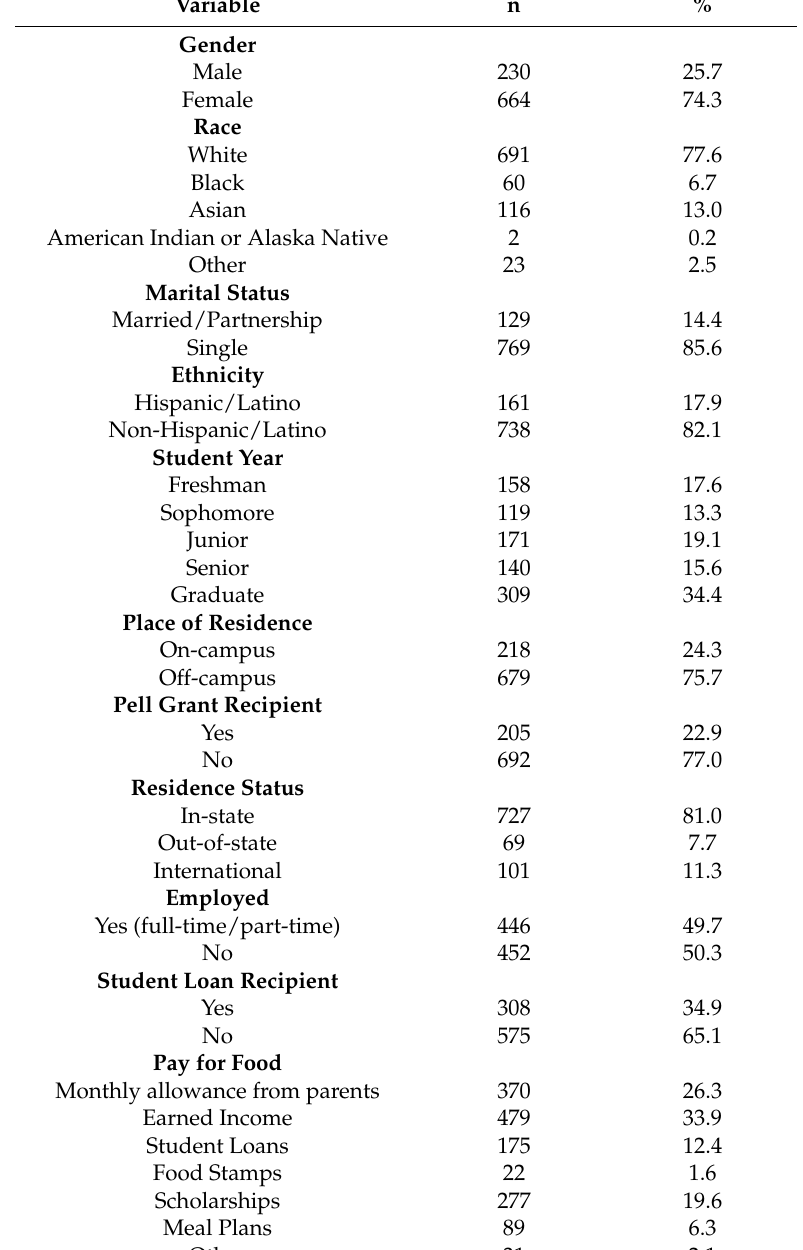
Table 1. Characteristics of study population ( n = 899) a